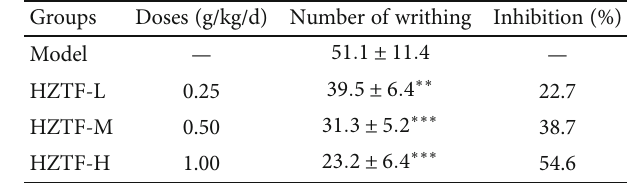
Table 4: E ff ects of HZTF on xylene-induced ear swelling in mice ( n = 10 ).